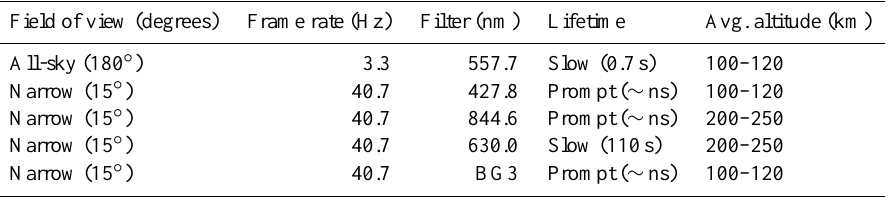
Table 2. Summary of the auroral imager operations during the 2011–2012 auroral season, when these NEIAL observations were made.